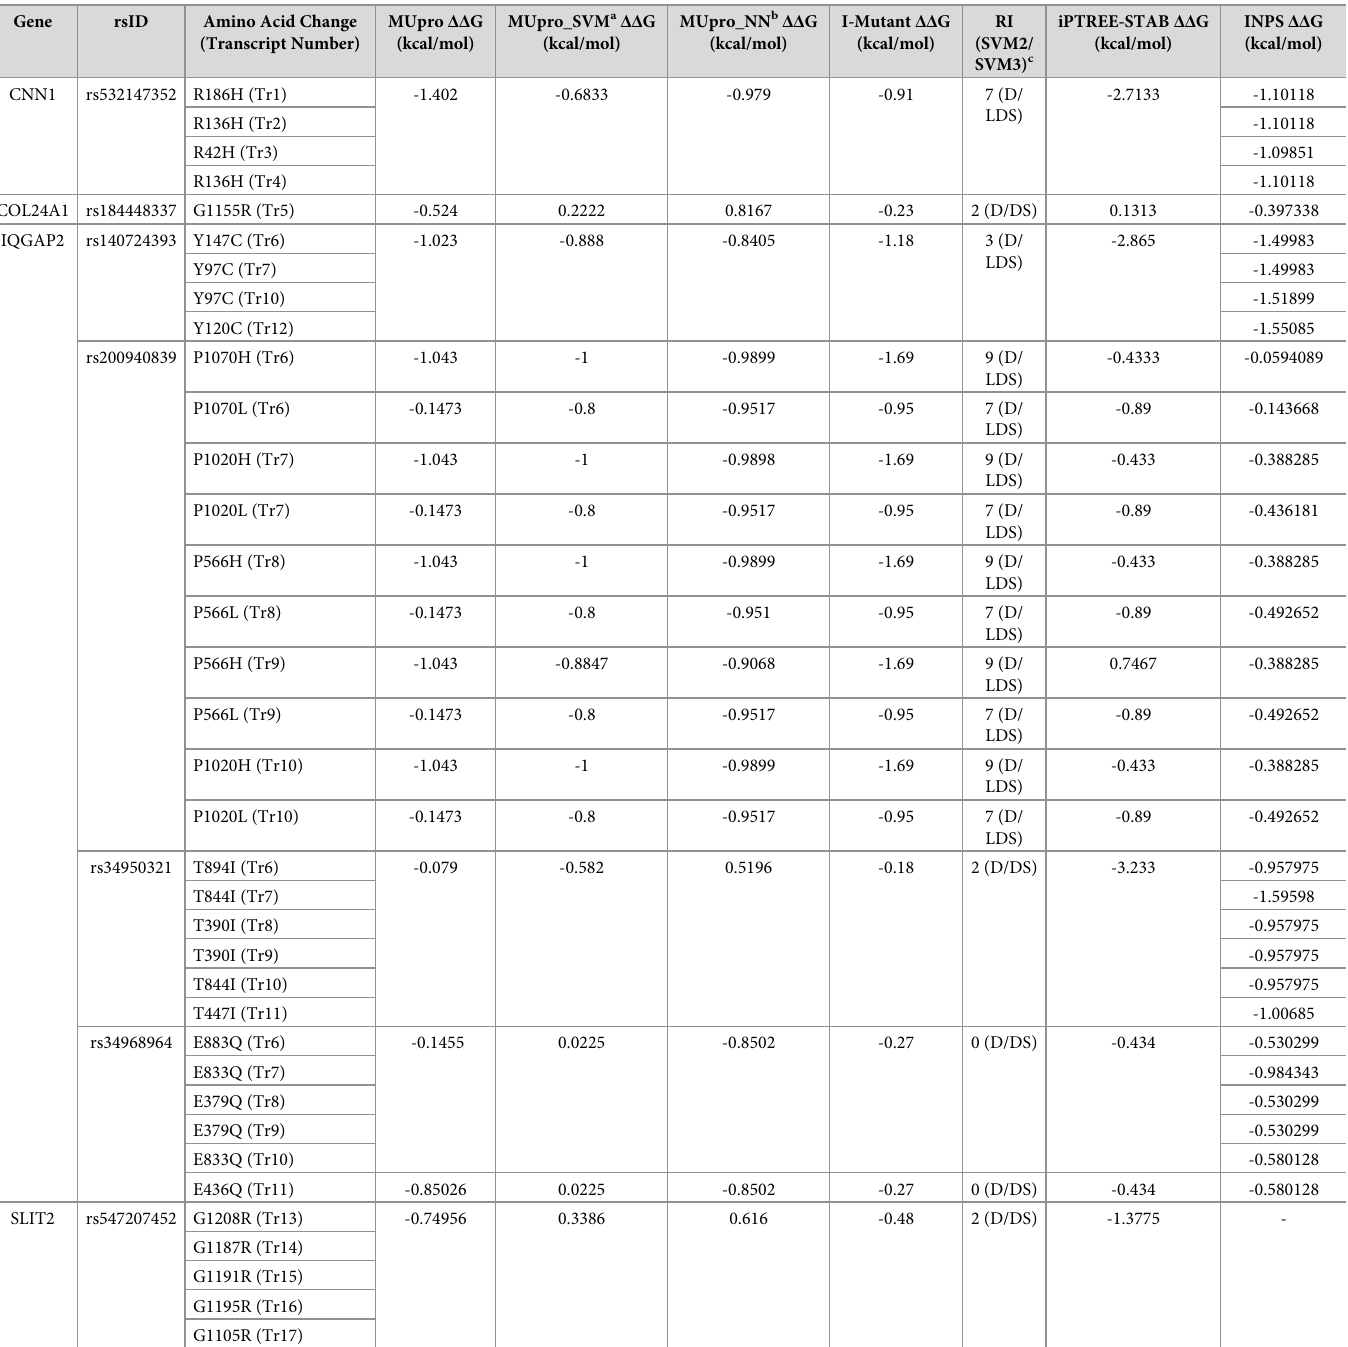
Table 4. Transcript-based computation of changes in free energy of amino acids of rare nsSNPs of PTB-related genes.